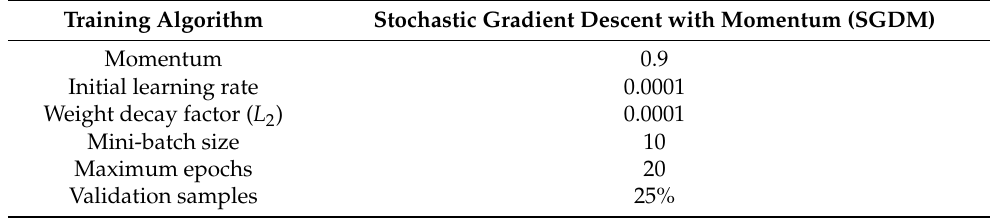
Table 3. Training properties of the